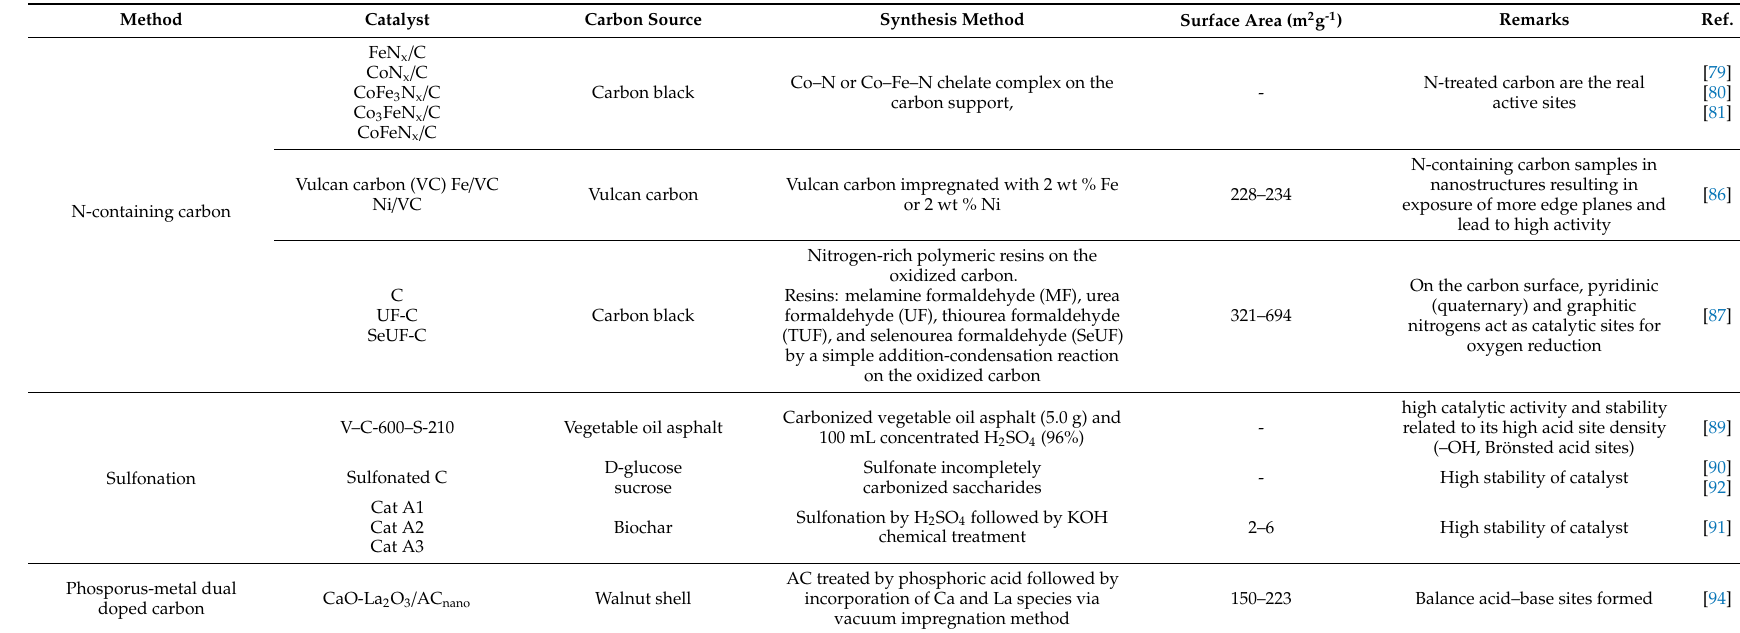
Table 2. Summary of carbon-based catalysts development